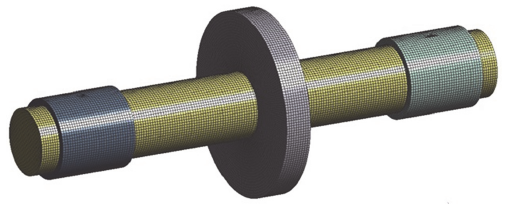
Figure 3: The finite element model of the rotor system. Table 2: The change of the eccentricity with the grid number. Grid number